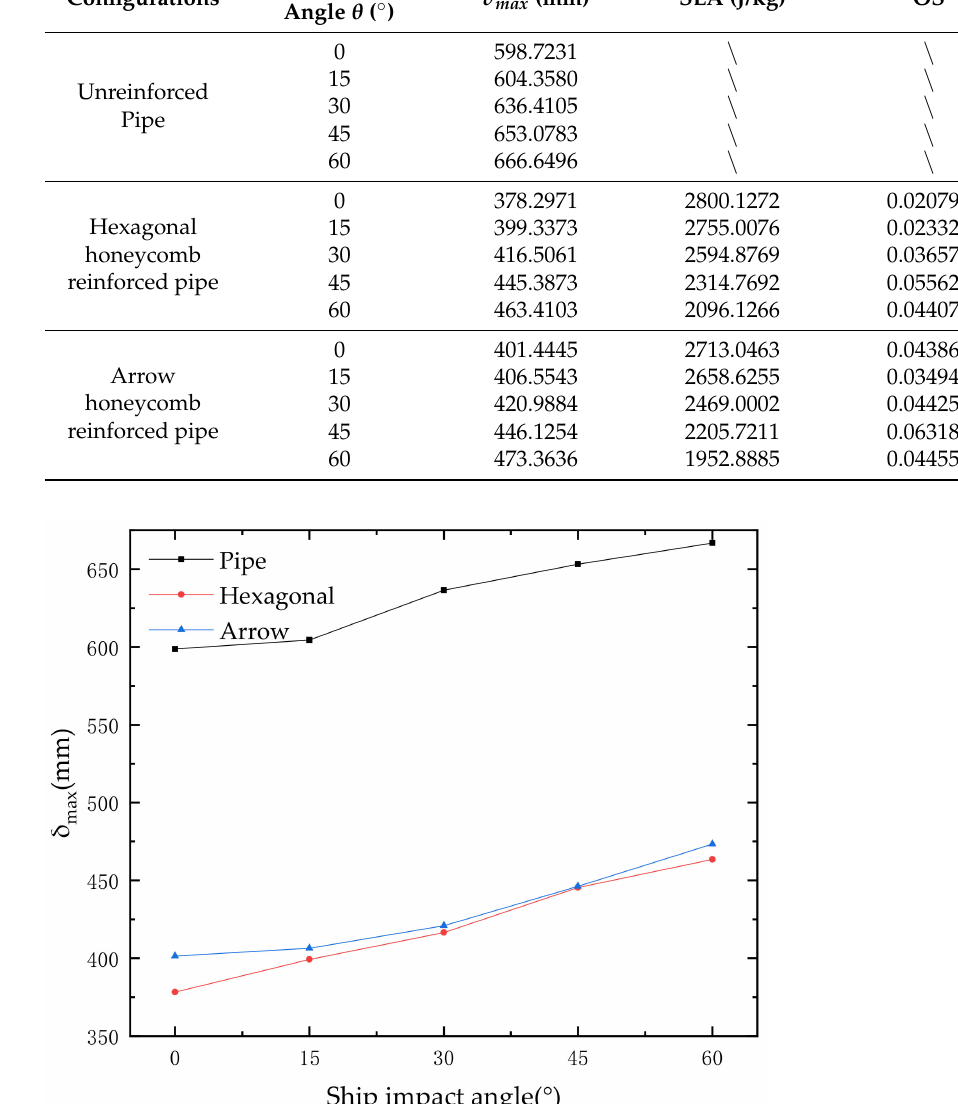
Figure 23. δ max –impact angle